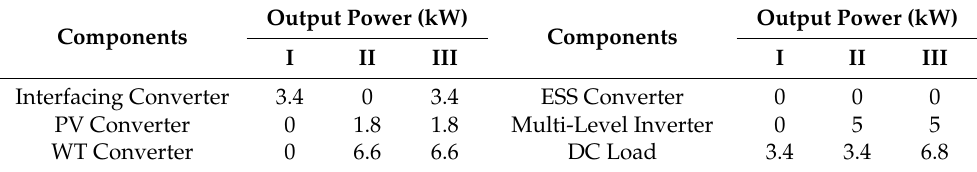
Table 6. Output power of each power conversion devices in mode 6.